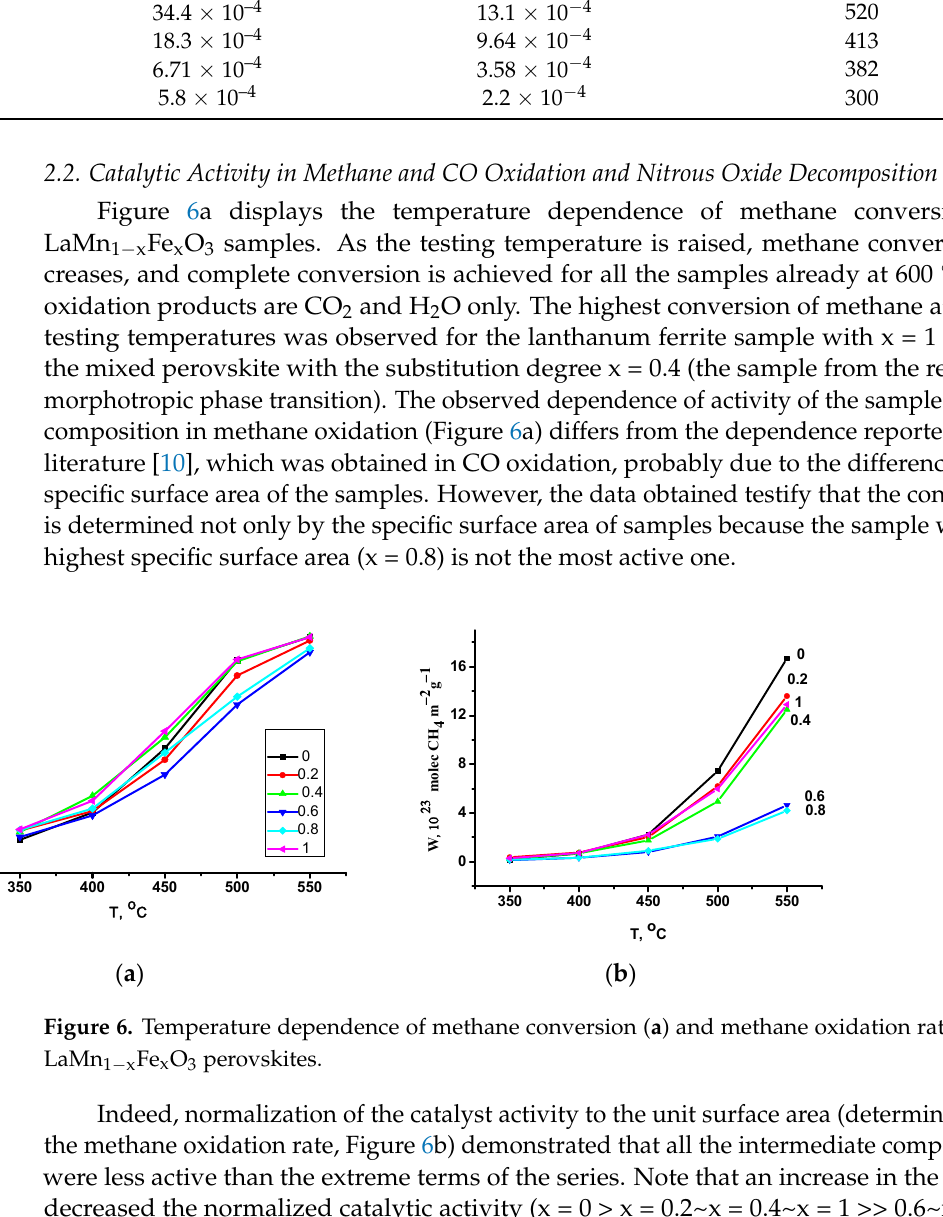
Figure 5. H 2 -TPR curves for LaMn 1 −х Fe х O 3 samples.